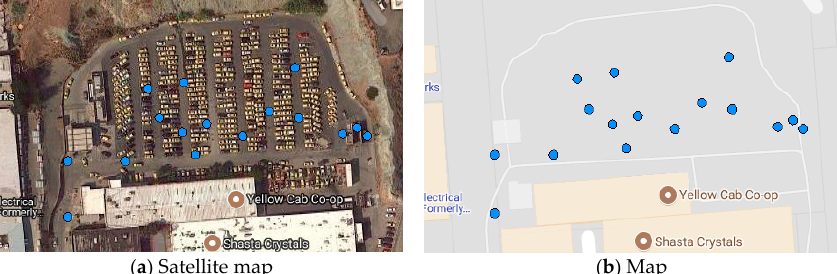
Figure 5. The densest area of stay places in San Francisco at 9:18 on 26 May 2008. The results are detected based on dataset DS1 .